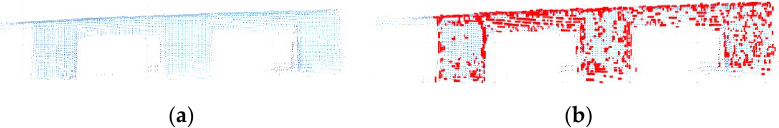
Figure 16. Key point extraction for target point cloud. ( a ) Target pallet point cloud. ( b ) Target pallet